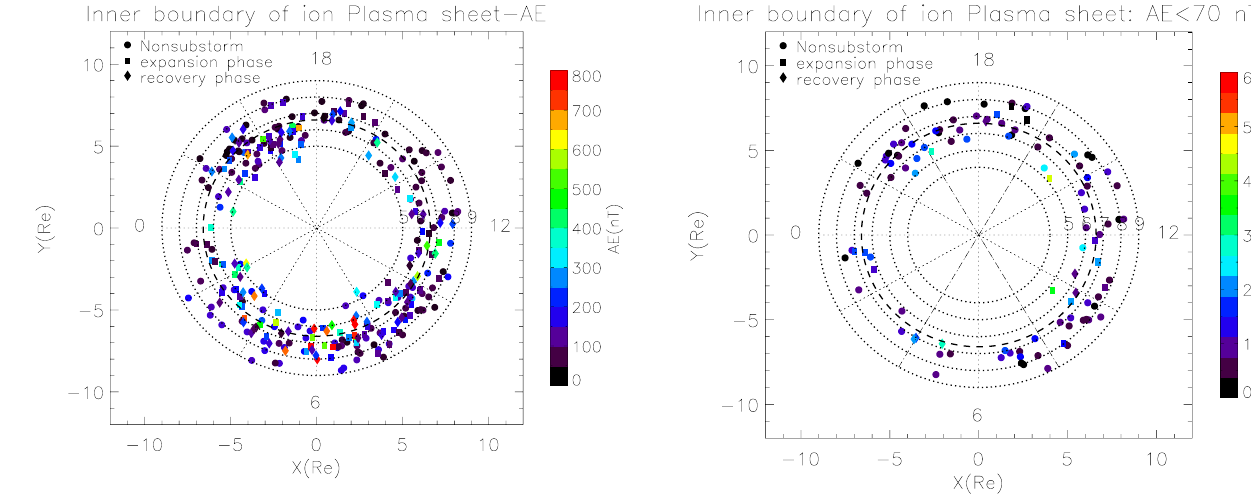
Fig. 5. The scatter plot of inner boundary of ion plasma sheet de- tected by TC-1 in the X-Y GSM plane for AE < 70nT color-coded according to Kp index. The symbols of circle, square and diamond represent non-substorm, expansion phase and recovery phase, re-